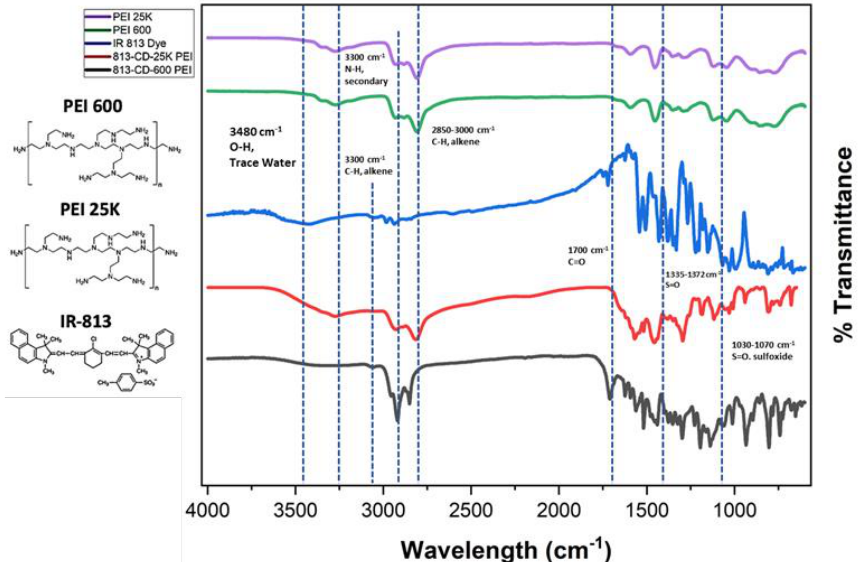
Figure 5. FTIR off-set spectra of PEI 25K, PEI 600, IR-813 dye, 813-CD-25k PEI, and 813-CD-600 PEI, respectively.